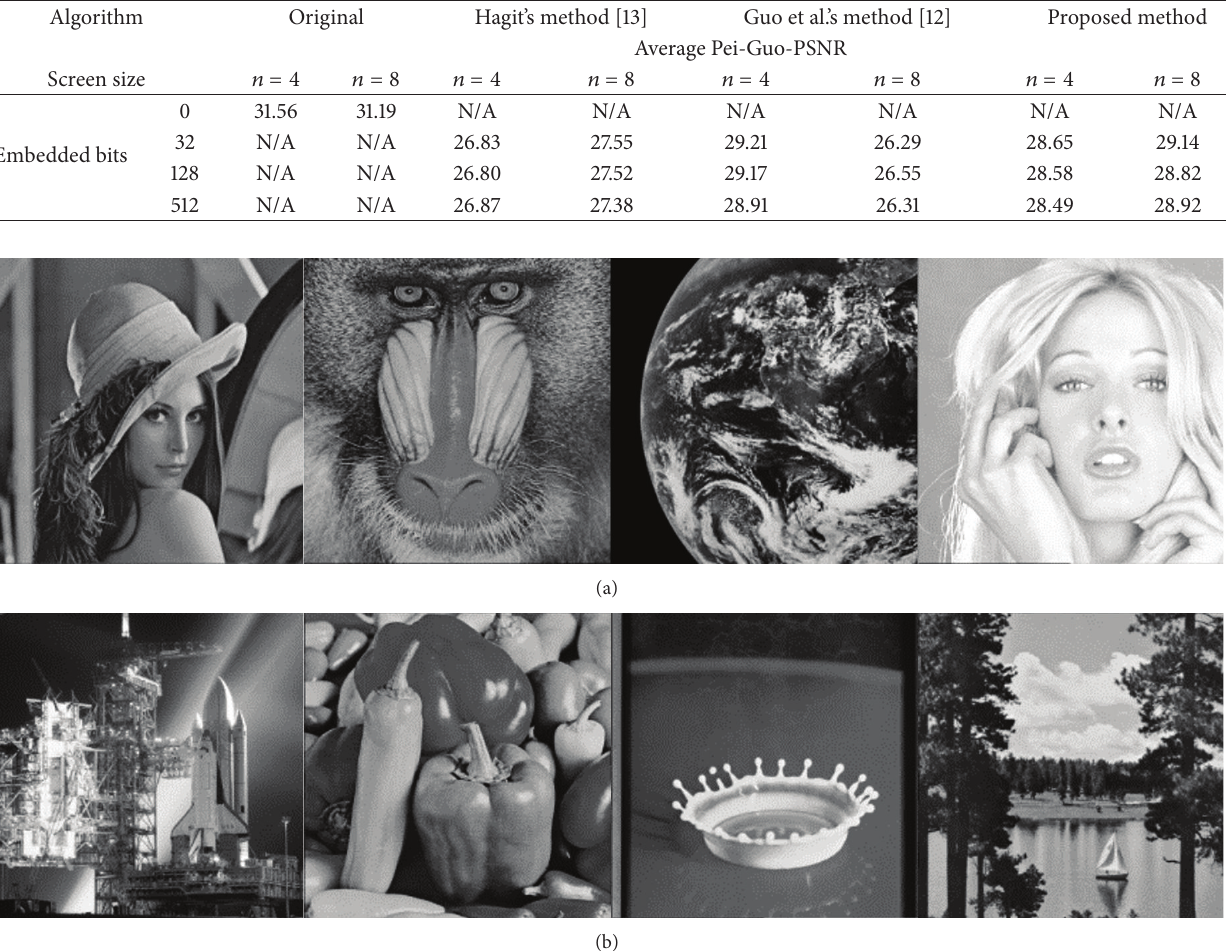
Figure 6: Thumbnail of eight test images. (a) Lena, Mandrill, Earth, and Tiffany. (b) Shuttle, Peppers, Milk, and Lake.